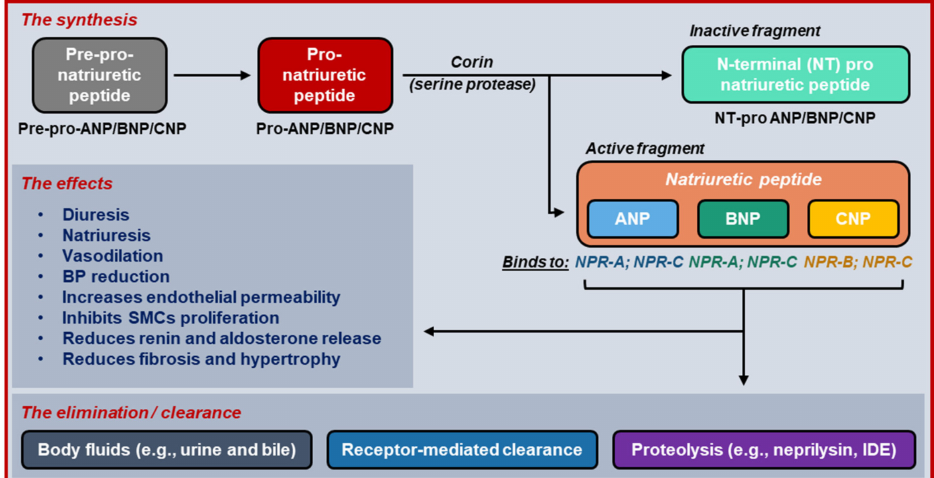
Figure 2. The life cycle of natriuretic peptides. Natriuretic peptides are synthesized and secreted by atrial cardiomyocytes (ANP), ventricular cardiomyocytes (BNP) and vascular endothelium (CNP) in their inactive pre-pro-form. In the presence of stimuli, the pre-pro-natriuretic peptides are converted into pro-natriuretic peptides and then cleaved by corin into both active and inactive fragments. After exerting its effects, natriuretic peptides are eliminated via three mechanisms, including degradation by neprilysin, a membrane-bound proteolytic enzyme. (ANP = atrial natriuretic peptide; BNP = brain natriuretic peptide; BP = blood pressure; CNP = C-type natriuretic peptide; IDE = insulin-degrading enzyme; NPR = natriuretic peptide receptor; SMC = smooth muscle